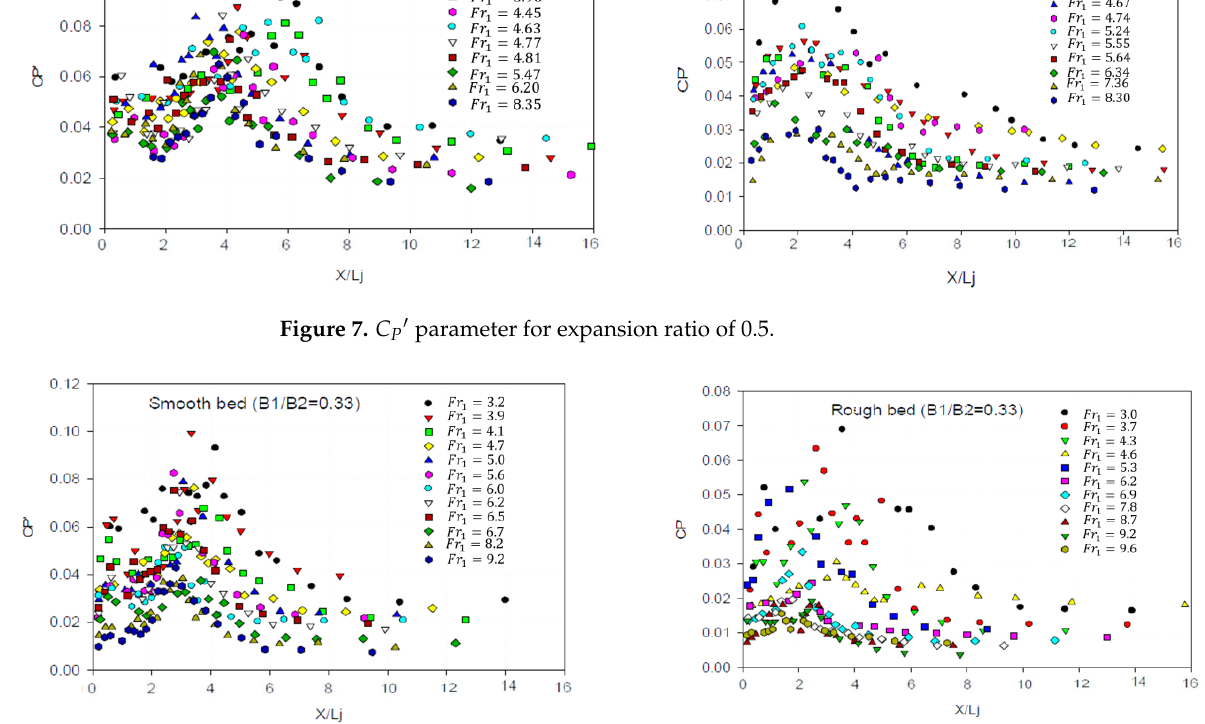
(cid:48) parameter for expansion ratio of Figure 8. 𝐶 𝑃′ parameter for expansion ratio of 0.33. Figure 8. C P Figure 8. 𝐶 𝑃′ parameter for expansion ratio of 0.33.